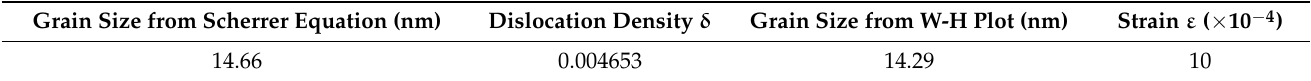
Figure 2. Crystalline structure, grain size, and particle size of green synthesized Ag NPs: ( a ) XRD pattern; ( b ) W-H plot; and ( c ) DLS plot. Table 2. Grain size, dislocation density and strain values obtained from XRD